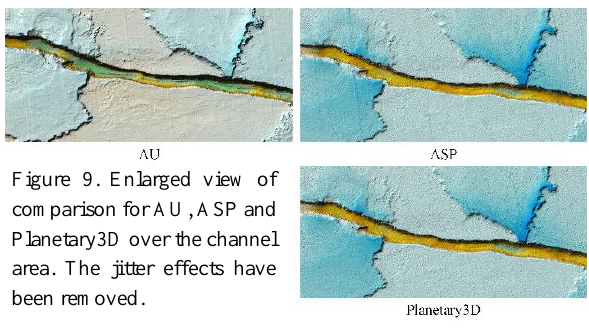
Figure 9. Enlarged view of comparison for AU, ASP and Planetary3D over the channel area. The jitter effects have been